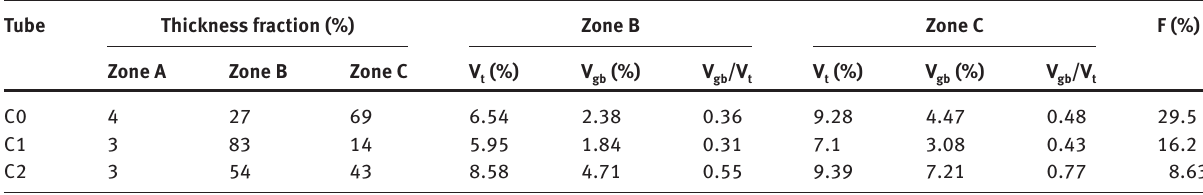
Table 2: Thickness fraction of macrostructures and volume fraction of eutectic carbides in cast tubes [12].